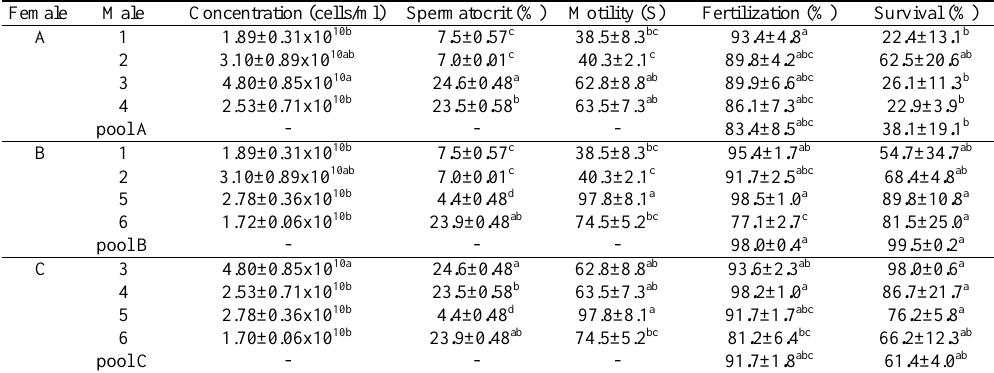
Table 2. Mean values and standard deviation of sperm concentration, spermatocrit, sperm motility duration, fertilization rate, and larval survival for each cross. abc In the same column and for each female, means followed by different letters are significantly different (p <